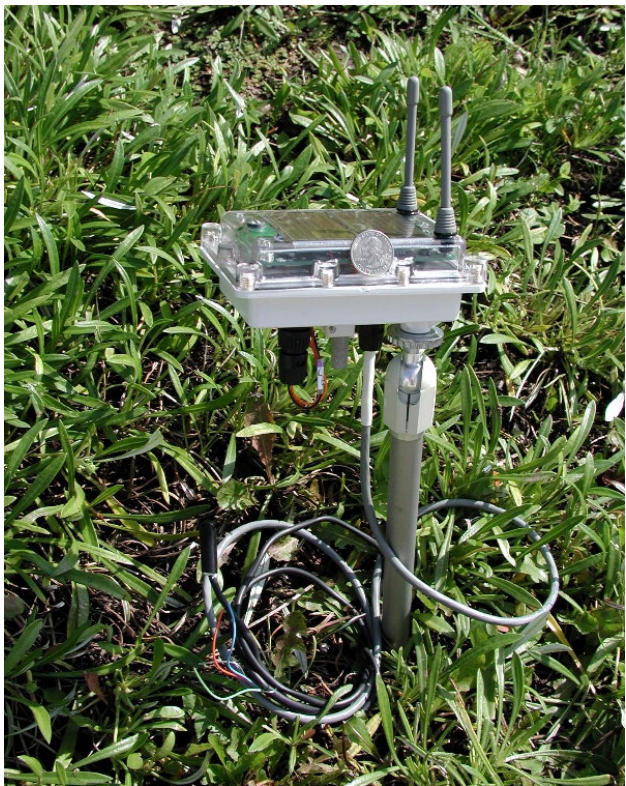
Figure 9. Sensor Web 3 pod. Note the quarter resting on the top. Sensors meant for subterranean measurements (temperature, moisture) can be separately connected as shown.